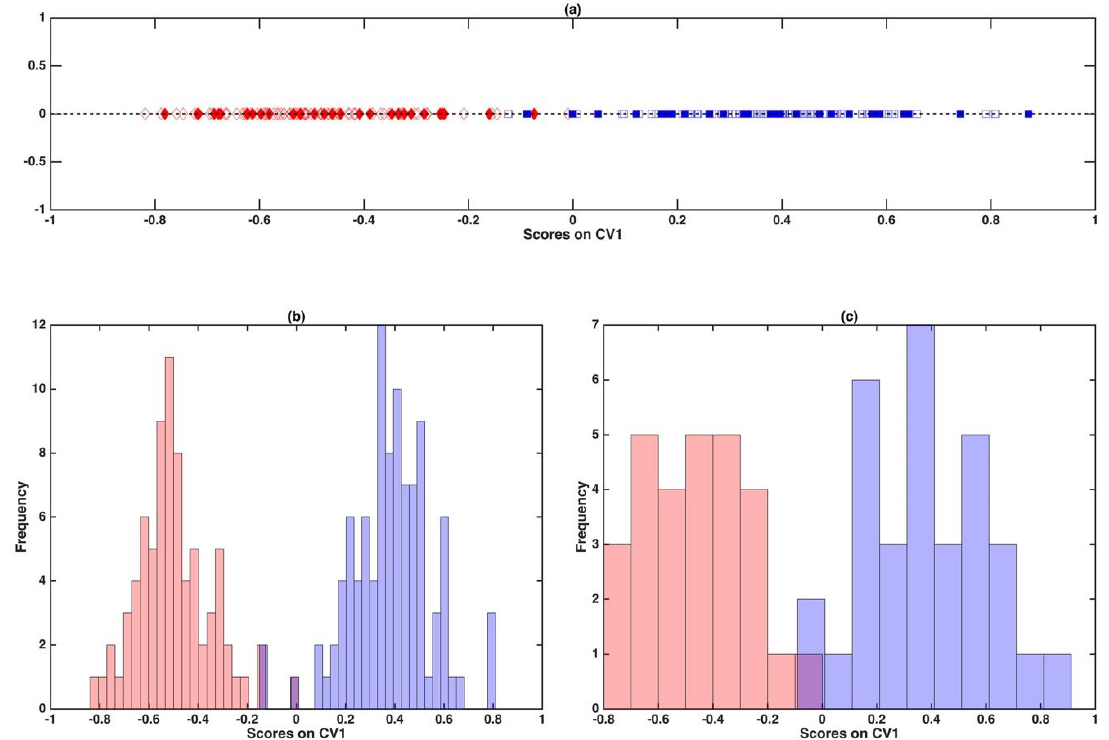
Figure 6. Sequential and Orthogonalized Partial Least Squares Linear Discriminant Analysis (SO-PLS- LDA) analysis: Investigation of the canonical variate. ( a ) Plot of the samples’ scores onto the only canonical variate for the training (empty symbols) and test (filled symbols) sets. Legend: Sorrento— red diamonds, Non-Sorrento—blue squares; ( b ) distribution of scores for the calibration model; ( c ) distribution of scores for the validation model